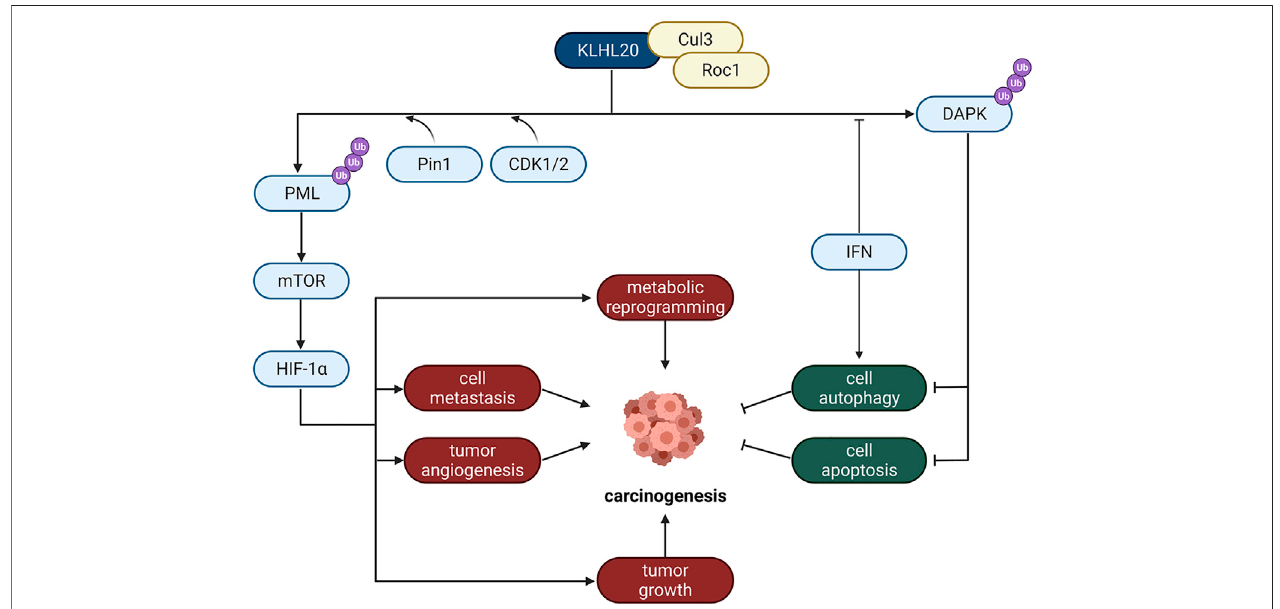
FIGURE 4 | The role of Golgi localized E3 ligases in cancer. KLHL20 is an important Golgi E3 protein, which regulates carcinogenesis through many different pathways, including metabolic reprogramming, cell metastasis, tumor angiogenesis and tumor